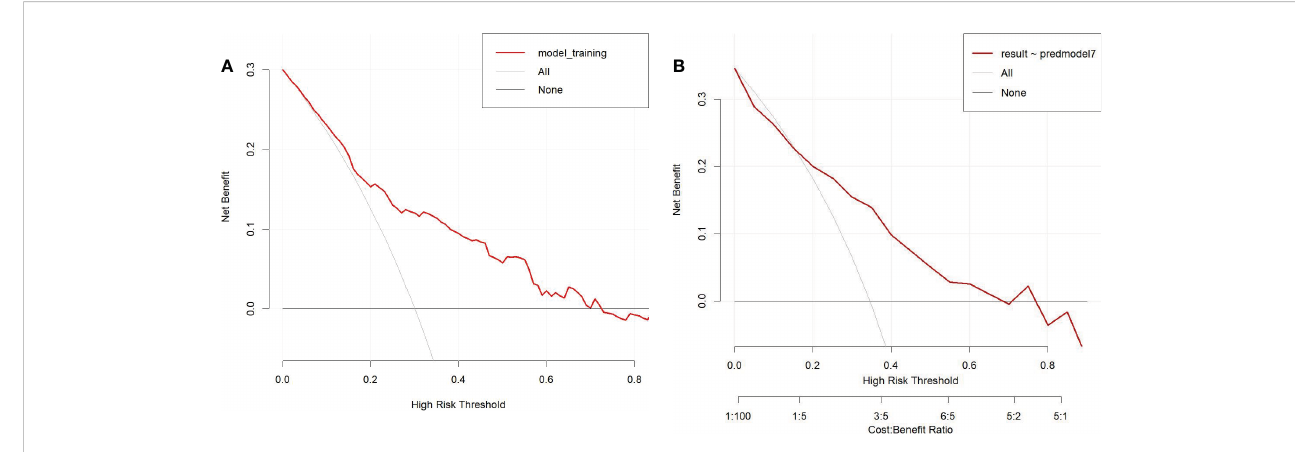
FIGURE 5 Decision curve analysis in prediction model (A) Training cohort. (B) Validation